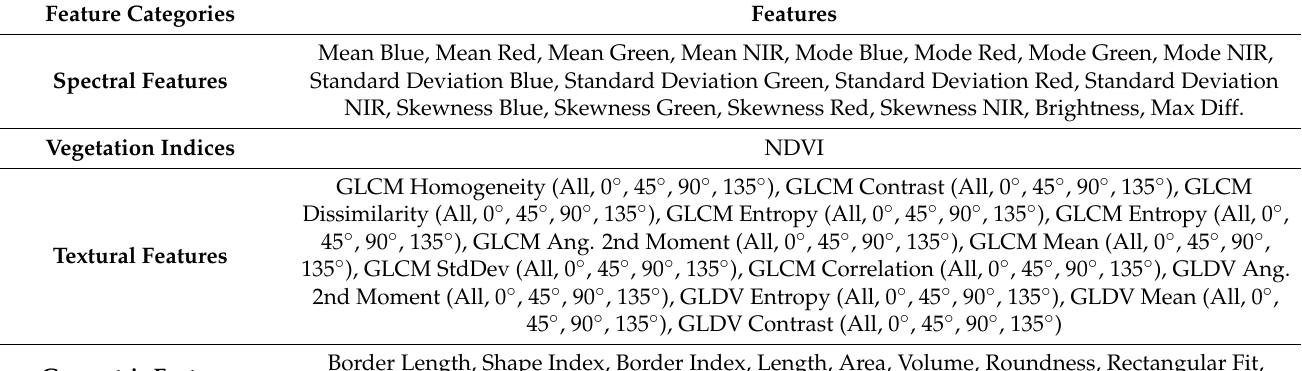
Table 2. List of spectral, textural, and geometric features of the image